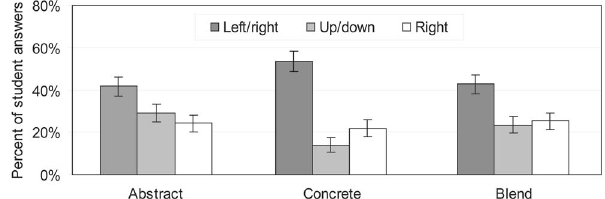
FIG. 13. Student answers to the sound waves quiz question 3 according to experimental group. The correct answer is the left- most dark gray bar (cid:1) left/right